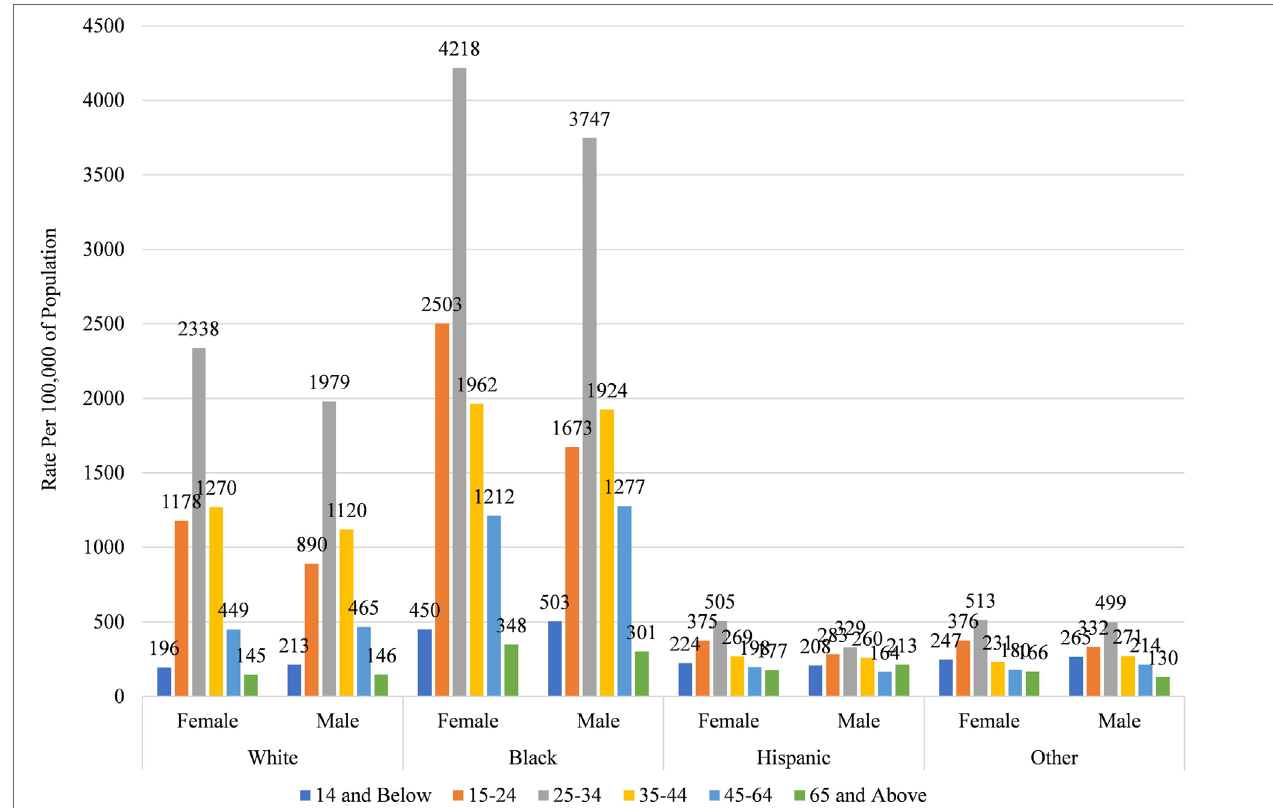
FigUre 2 | Rate of dental/oral health related conditions discharges by race, gender, and age in Maryland